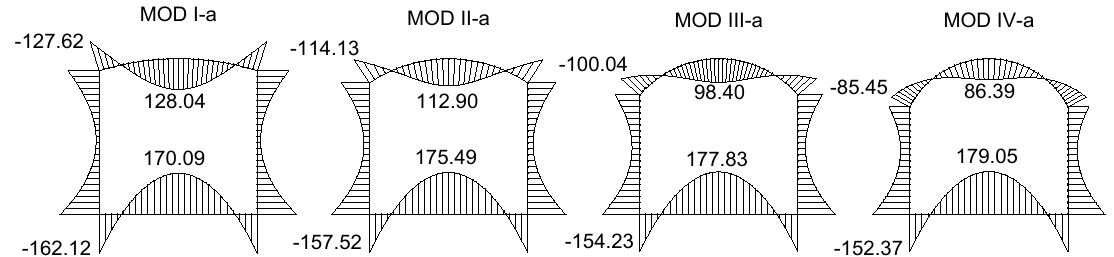
Figure 8. Bending moment diagrams (kN·m) for the modified culvert - Serie a (H =